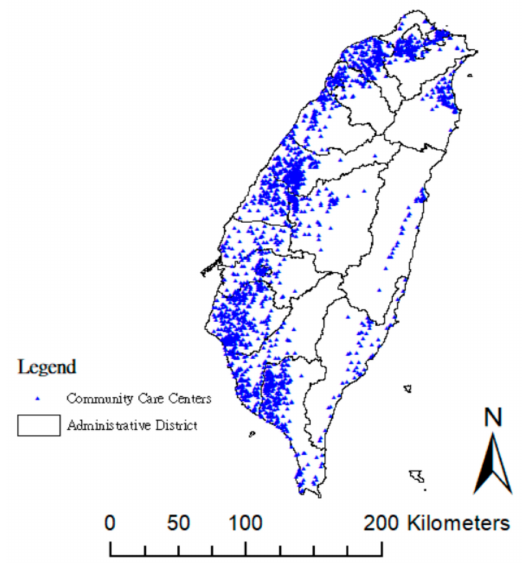
Figure 2. Geographic distribution of community care centers in Taiwan,